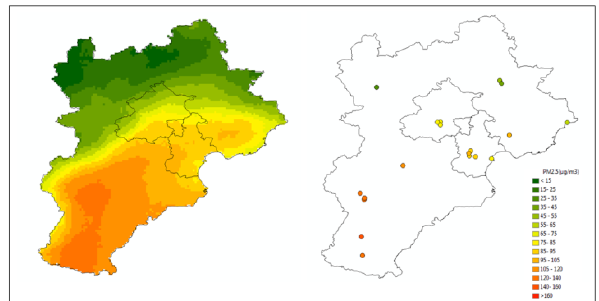
Figure 3.The spatial distribution of the annual PM 2.5 concentration from developed GWR model (left) and comparison with ground observation (RMSE=18.6μg/m 3 ) standard concentration (35μg/m 3 ) in cold seasons (winter and autumn). This verifies the role that heating system plays in pollution by utilizing coal in study area. As can be seen there is a very good agreement between model performance and ground observations which determine the ability of our developed GWR model for PM 2.5 estimation. The mean annual concentration of PM 2.5 derived from GWR is shown in figure (3). As it is illustrated, most of study area face with moderate to unhealthy level of PM 2.5 concentration, except northern regions. Compared with ground control observations (19 stations) the annual mean RMSE gains 18.6μg/m 3 . This distribution pattern follows the distribution of PM 2.5 derived from GWR for entire china with RMSE 30μg/m 3 and 50 Km spatial resolution (Ma et al., 2014). Our model also exhibits better performance than a linear mixed effect model developed over BTH for 2013 with RMSE 23.1μg/m 3 (Zheng et al., 2016). Also this result is compatible with the mixed effect model developed by Xie et al. (2015) over Beijing with annual RMSE 18((μg/m 3 ). This slightly better result may due to the more ground stations (well distributed N=35) that were used to calibrate the